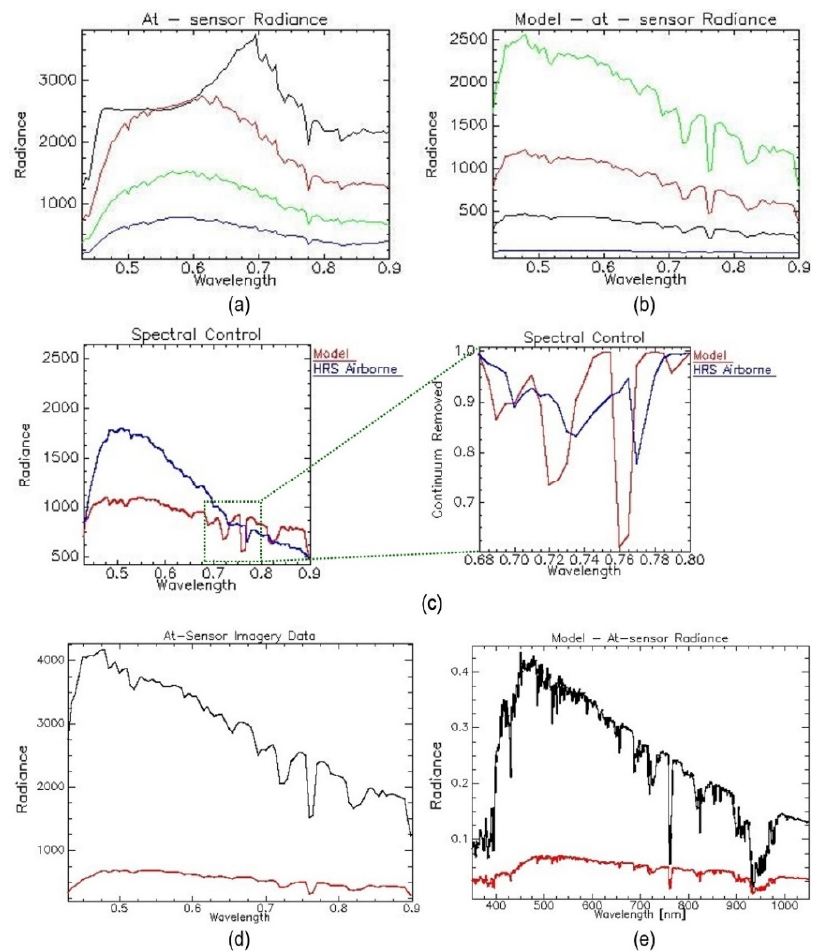
Figure 12. ( a ) Image at-sensor radiance and ( b ) modelled at-sensor radiance based on in situ measured reflectance (right side) of four selected ground targets. ( c ) Illustration of radiometric/spectral defects - investigation of image spectral accuracy based on atmospheric gas absorption (blue spectrum) compared with simulated radiance (red) spectrum for the same ground-truth target. ( d ) The modelled at-sensor radiance based on in situ measured reflectance and ( e ) image at-sensor radiance.